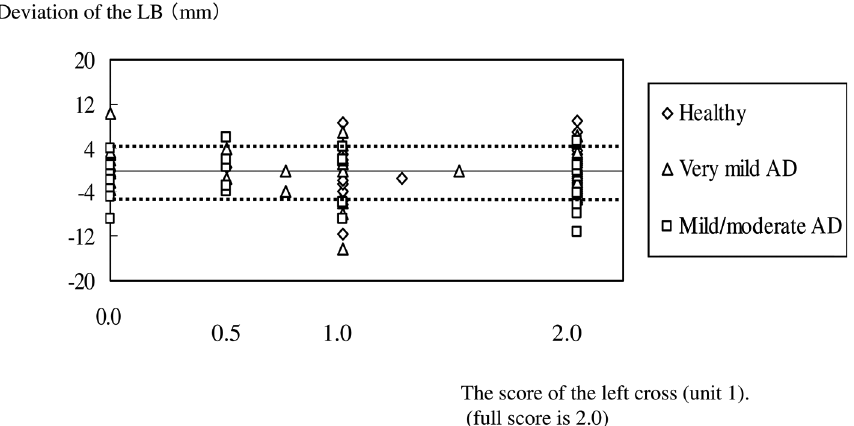
Figure 4. Deviations on the LB test and “left cross” scores for unit 1 in RCFT copying for healthy subjects, very mild AD patients, and mild/ moderate AD